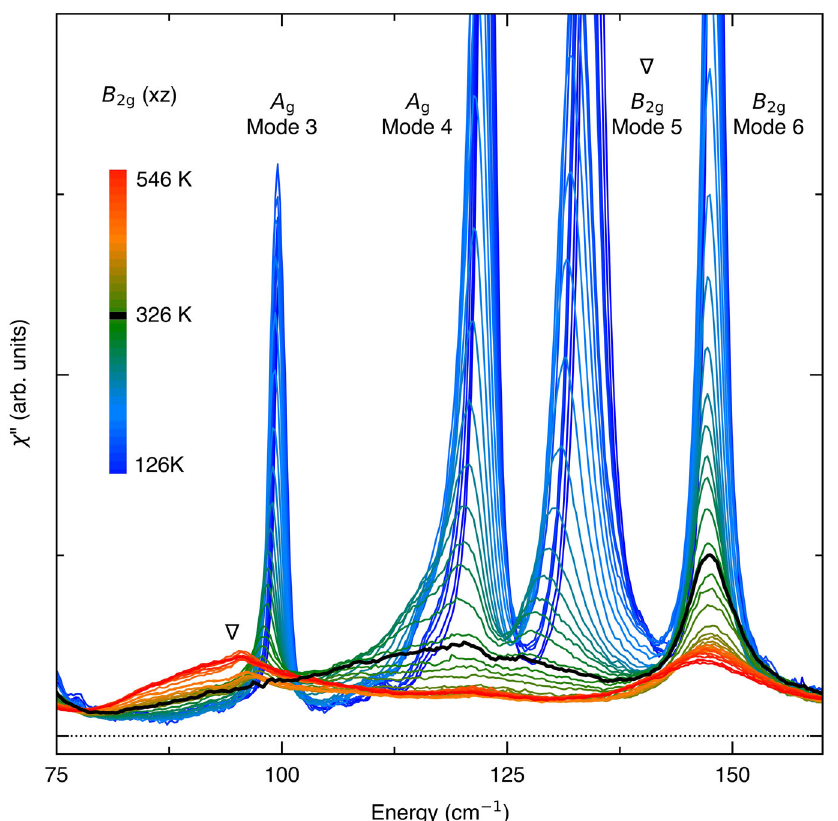
Fig. 4 Heavily damped B 2g phonons. B 2g Raman spectra from 126 K to 546 K. Mode 5 (inverted triangle) exhibits a large blue shift upon cooling, and is heavily damped close to the T C (black solid line). At the highest measured temperature, all three B 2g modes are identi fi ed: mode 2 (Fig. 3), 5, and 6. Below T C , A g modes 3 and 4 also become